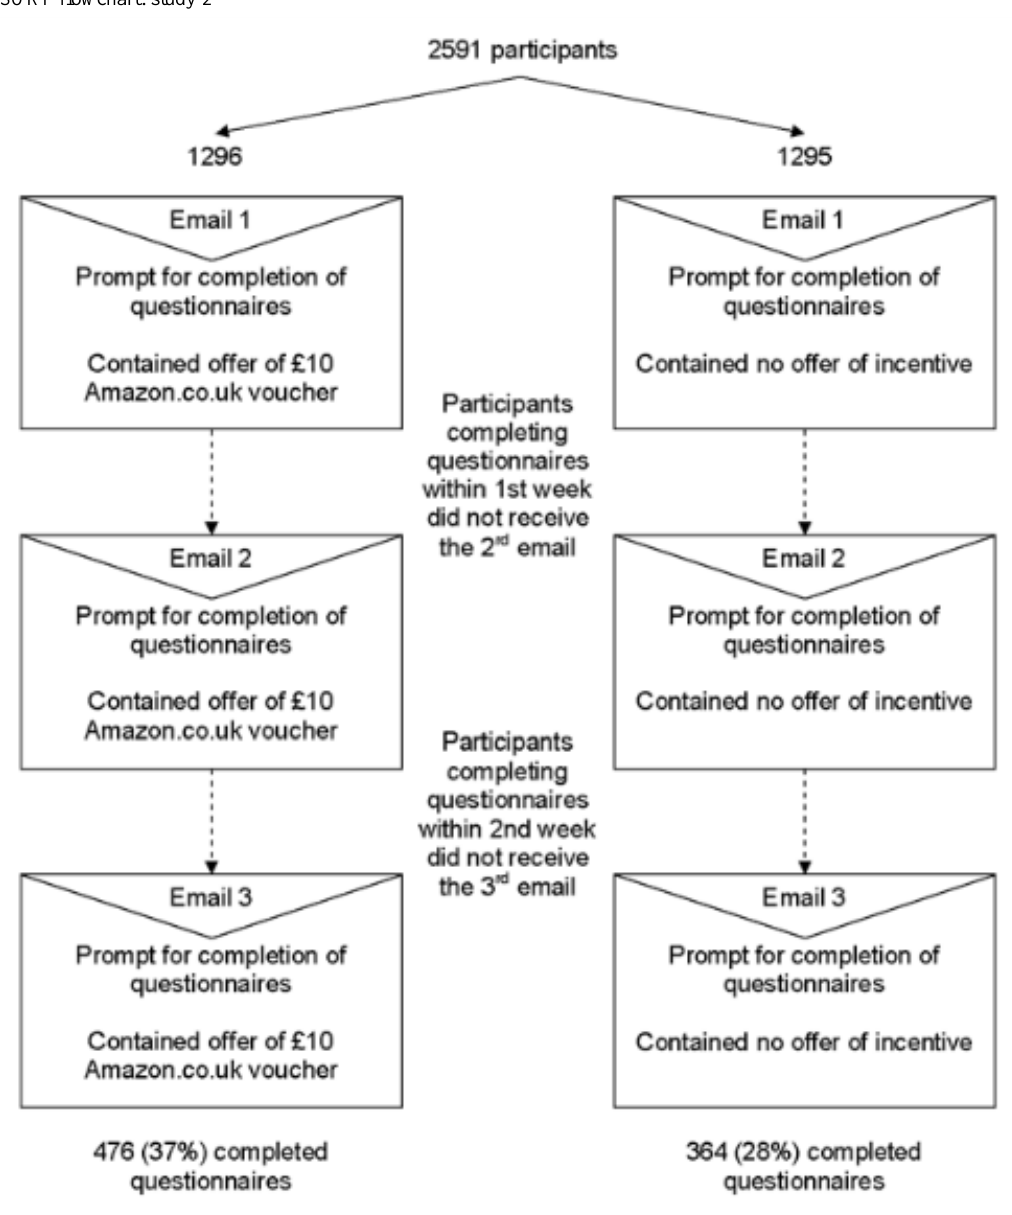
Figure 3. CONSORT flowchart: study